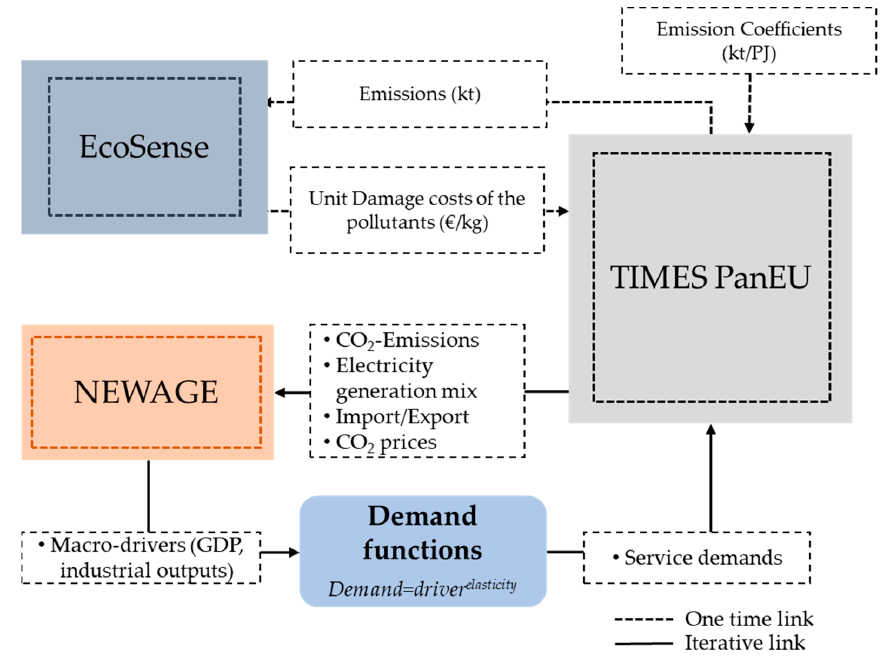
Figure 2. Integrated Assessment Toolbox — links between the models.